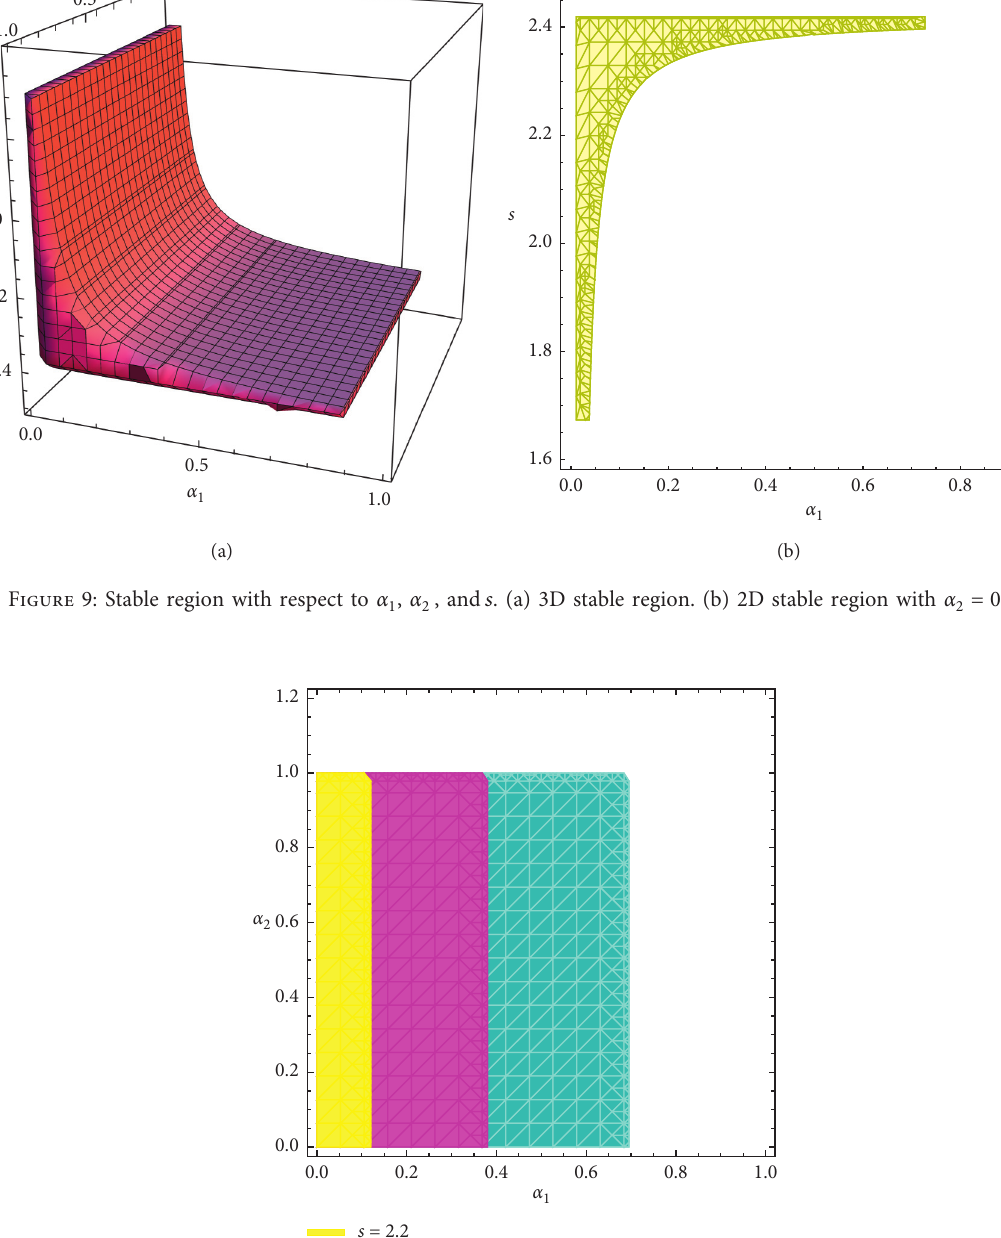
, α ) plane with different s 1 2